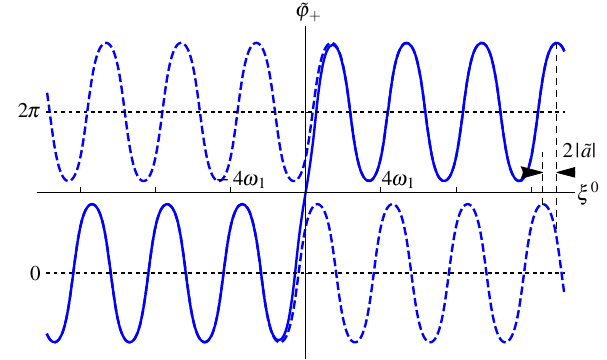
Fig. 2 The dressed solution for an oscillating seed with E = 9 μ 2 / 10 and Bäcklund parameter a = 2 at ξ 1 = 0. The dashed lines indicate the (cid:12) (cid:13) ξ 0 ± ˜ a asymptotic behaviour ϕ ˜ ϕ +